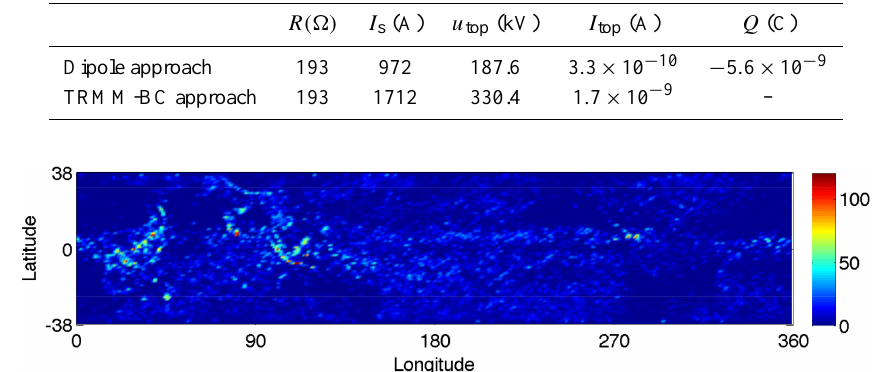
Table 3. Integrated quantities for WACCM conductivity with clouds, aerosols, and topography.